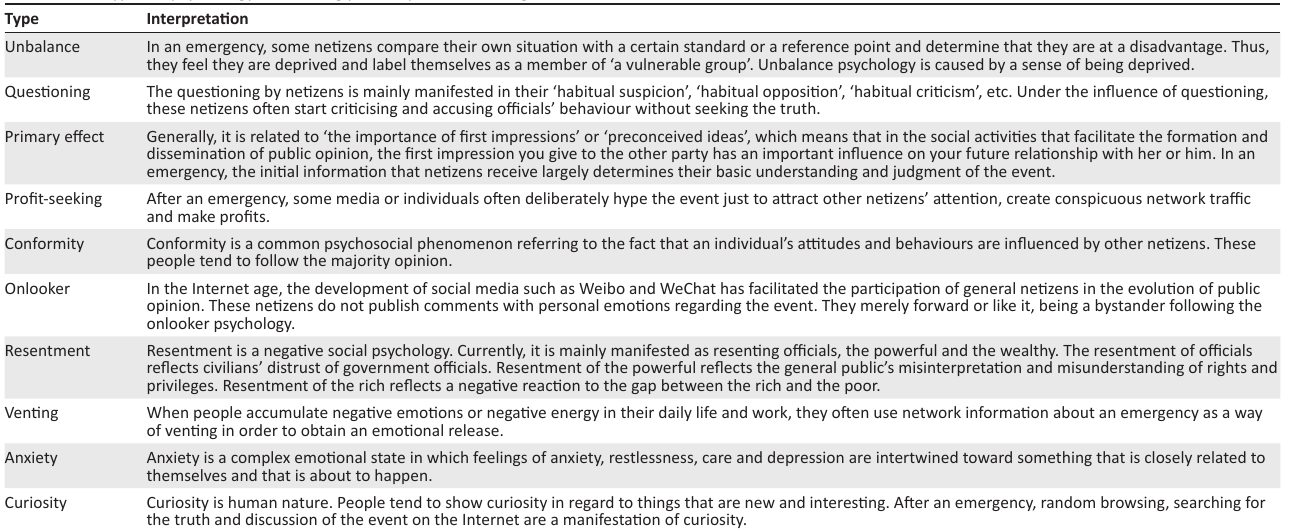
TABLE 3: Ten types of psychology concerning public opinion of